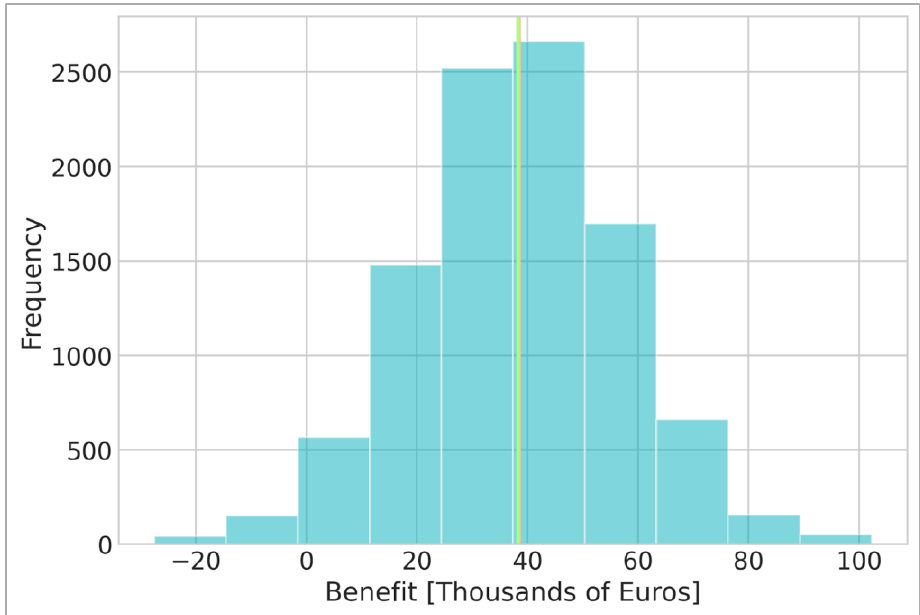
Figure A3. Distribution of estimated difference in net benefit between actual farm management and the expected income after drainage application. The distribution is based on an A/B test with 10,000 bootstrap resampling. The orange and green lines represent the mean and median difference in net benefit between current farm management and the expected benefit after drainage application.